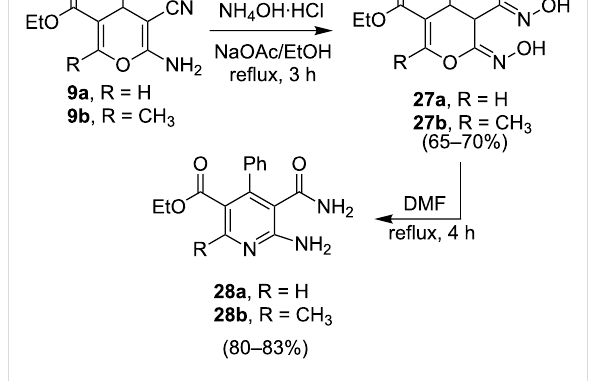
Figure 6: X-ray crystal structure of 27a .